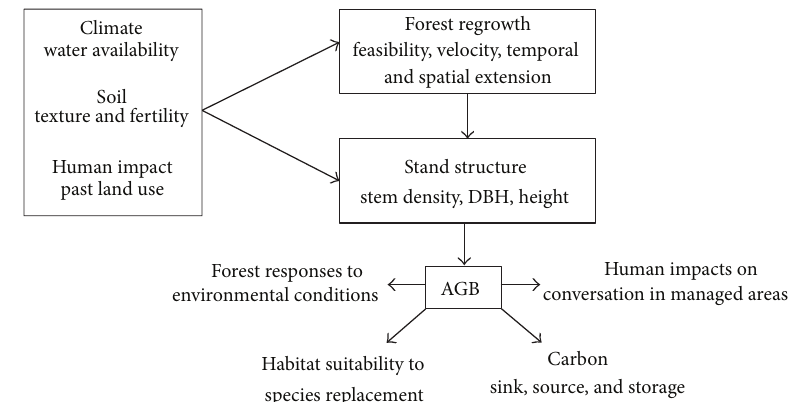
Figure 4: Climate, soil, and human activities determine the forest stand structure and the forest regrowth pattern. The estimated aboveground biomass (AGB) may be used as a variable to answer ecological issues, such as forest responses to environmental conditions, habitat suitability, carbon storage, and conservation in managed areas (adapted from Sarker et al.